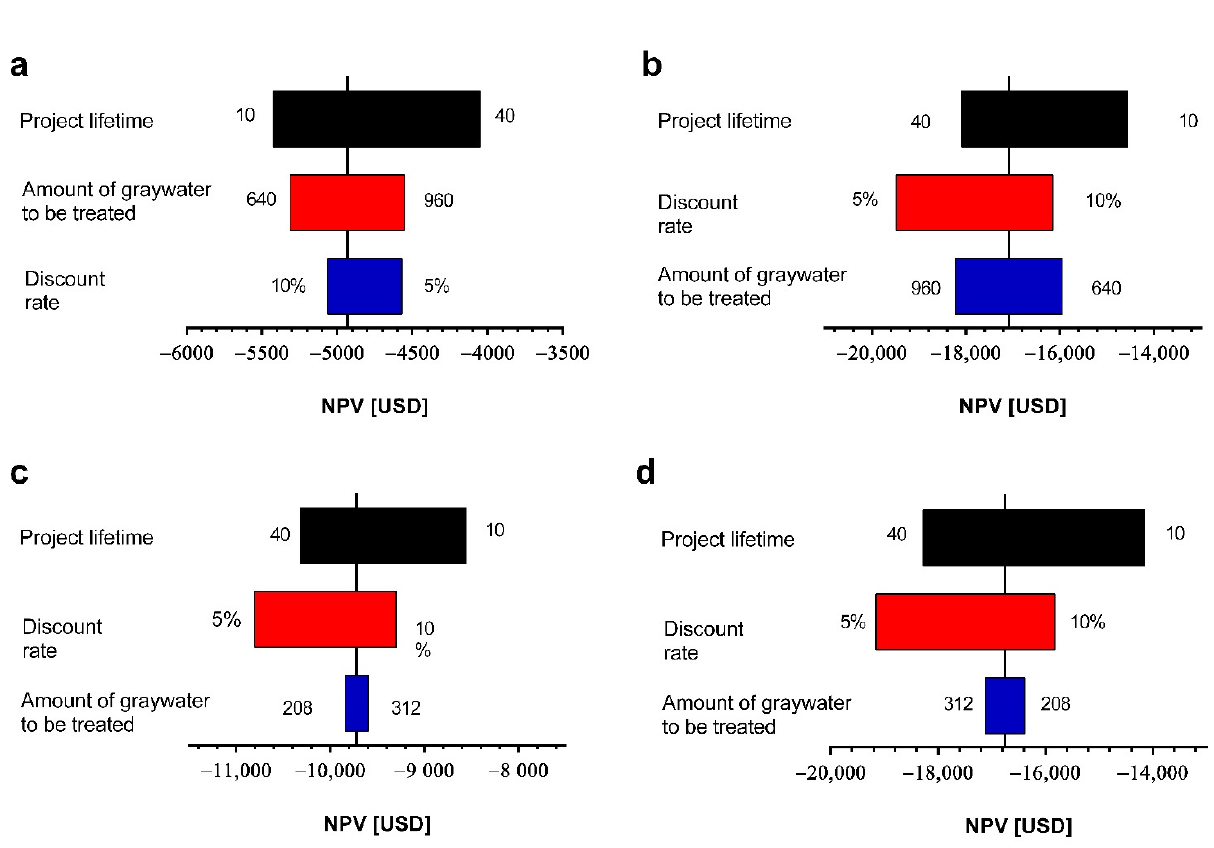
Figure 2. Sensitivity analysis of the variation of project lifetime, discount rate, and amount of greywater to be treated considering at ( a ) José Santos Ossa light greywater, ( b ) José Santos Ossa light and dark greywater, ( c ) Los Pozos Light greywater, and ( d ) Los Pozos light and dark greywater .